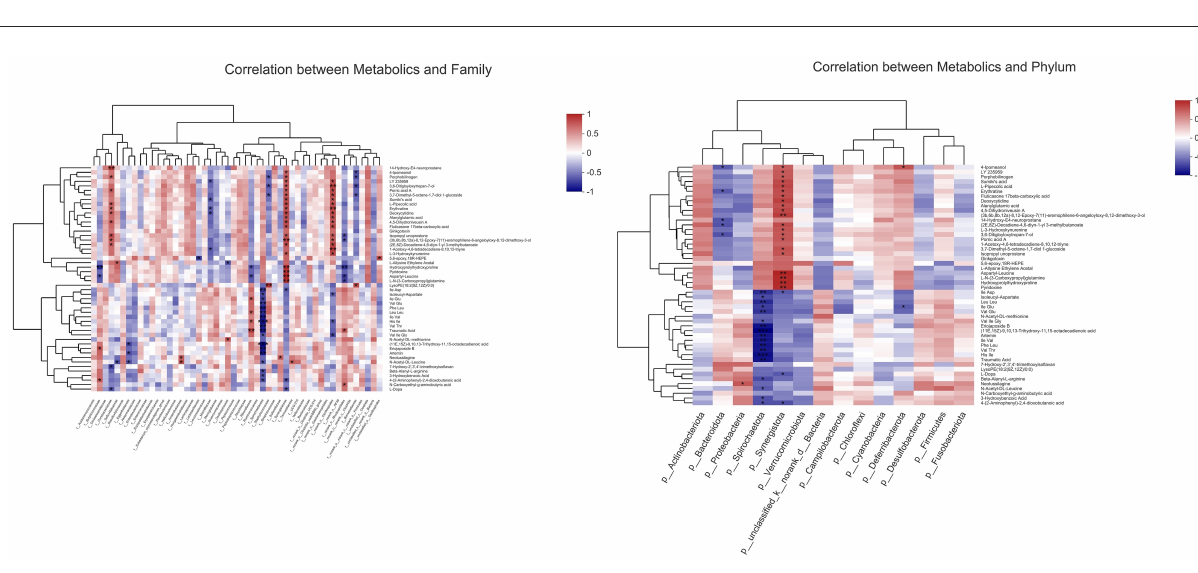
nicotinamide adenine dinucleotide phosphate (NADP + ) and NADPH, which are vital for resistance to oxidative stress (45,